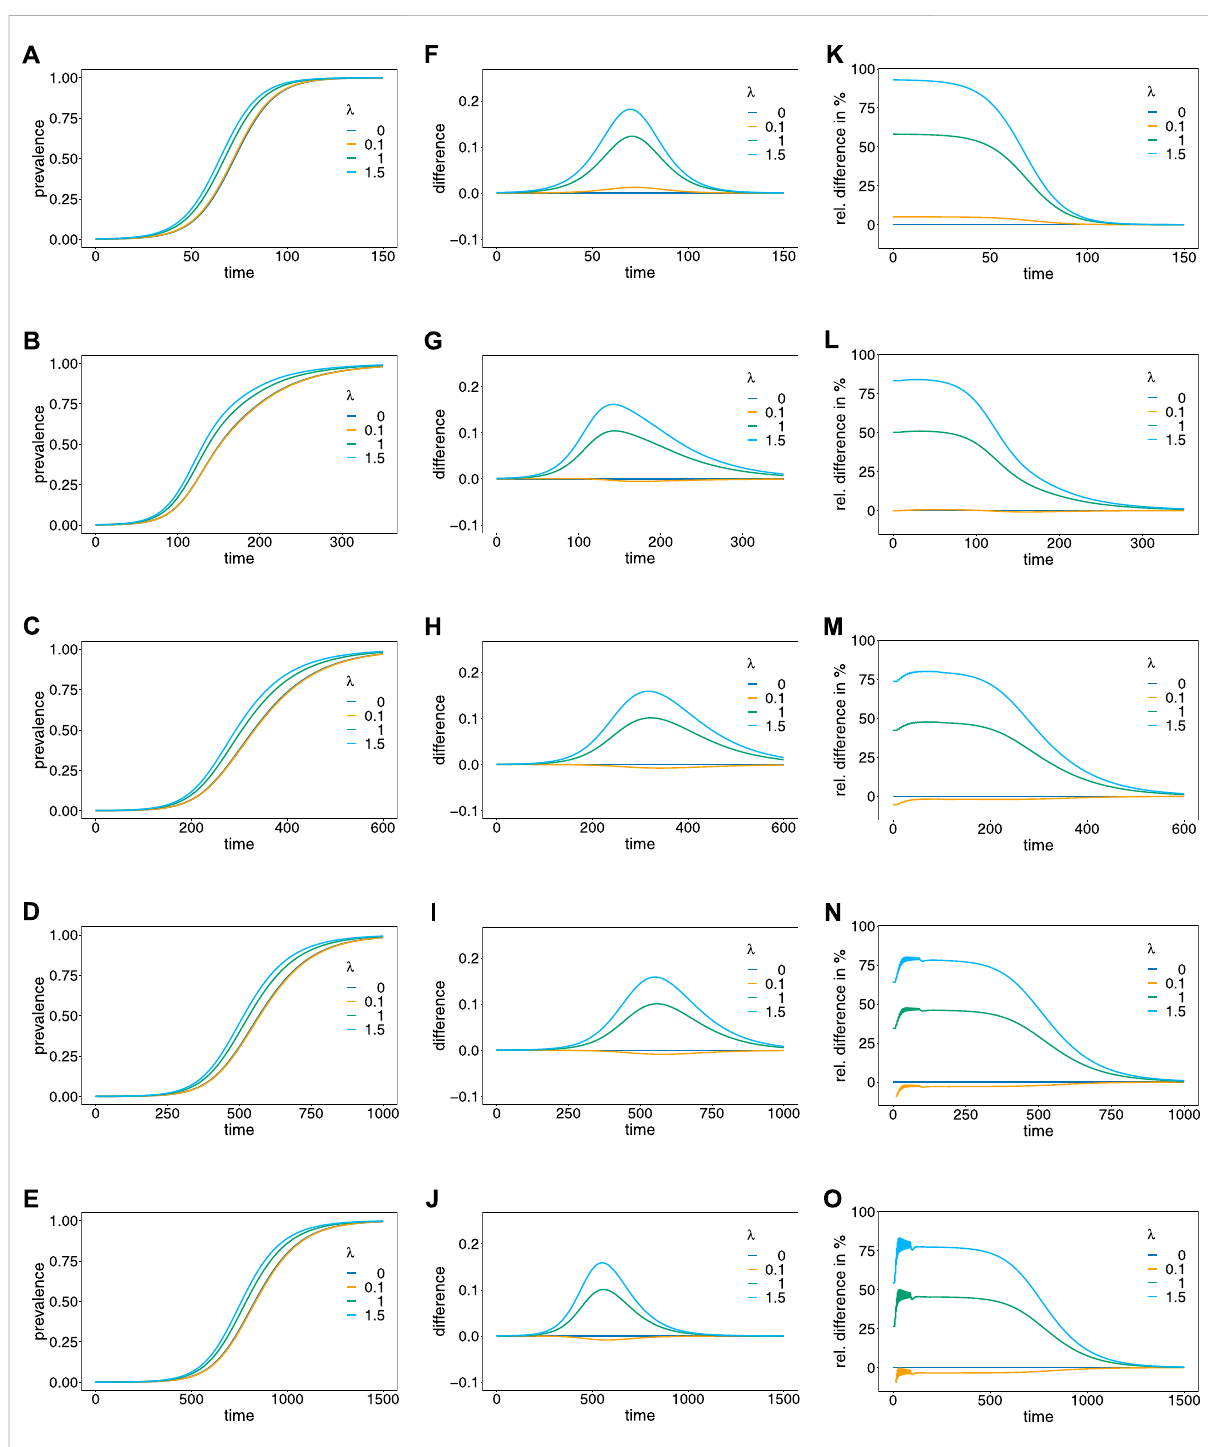
Prevalence. Panels (A – E) show the prevalence of the resistance-conferring allele corresponding to the dynamics in Figure 4A for different values of the Poisson parameter λ (colors). Panels (A – E) correspond to the dynamics with 0%, 5%, 10%, 15%, and 20% relapses, respectively. Panels (F – J) show the corresponding difference between prevalence and frequency, and panels (K – O) show the corresponding relative difference (prevalence minus frequency divided by frequency) in